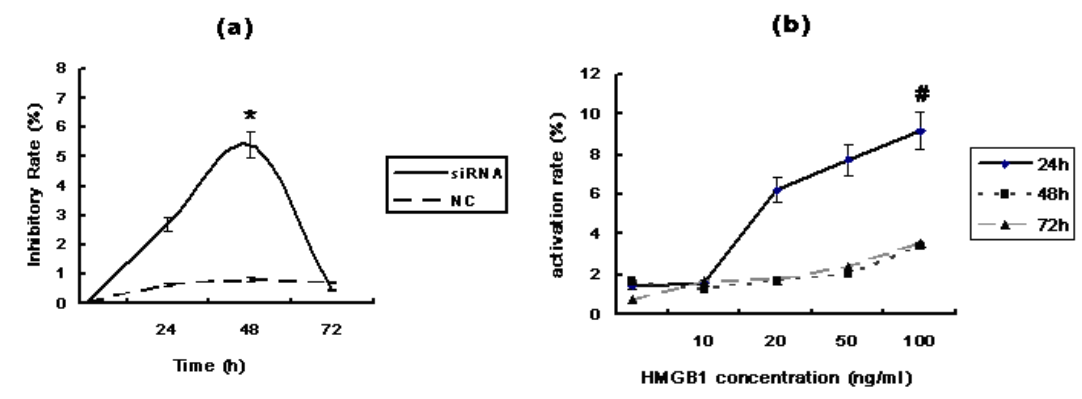
Figure 4. Cell proliferation was performed with the 3-(4,5-dimethylthiazol-2-yl)-2,5- diphenyltetrazolium bromide (MTT) colorimetric assay in Huh7 cells. ( a ) Cell growth inhibition caused by RAGE siRNA. The greatest growth inhibition was achieved after 48 h of incubation ( * p < 0.01); ( b ) Cell growth activation caused by HMGB1. The greatest growth activation was observed after 24 h of incubation (# p < 0.01). Three independent measurements were made and averaged. NC: Negative Control